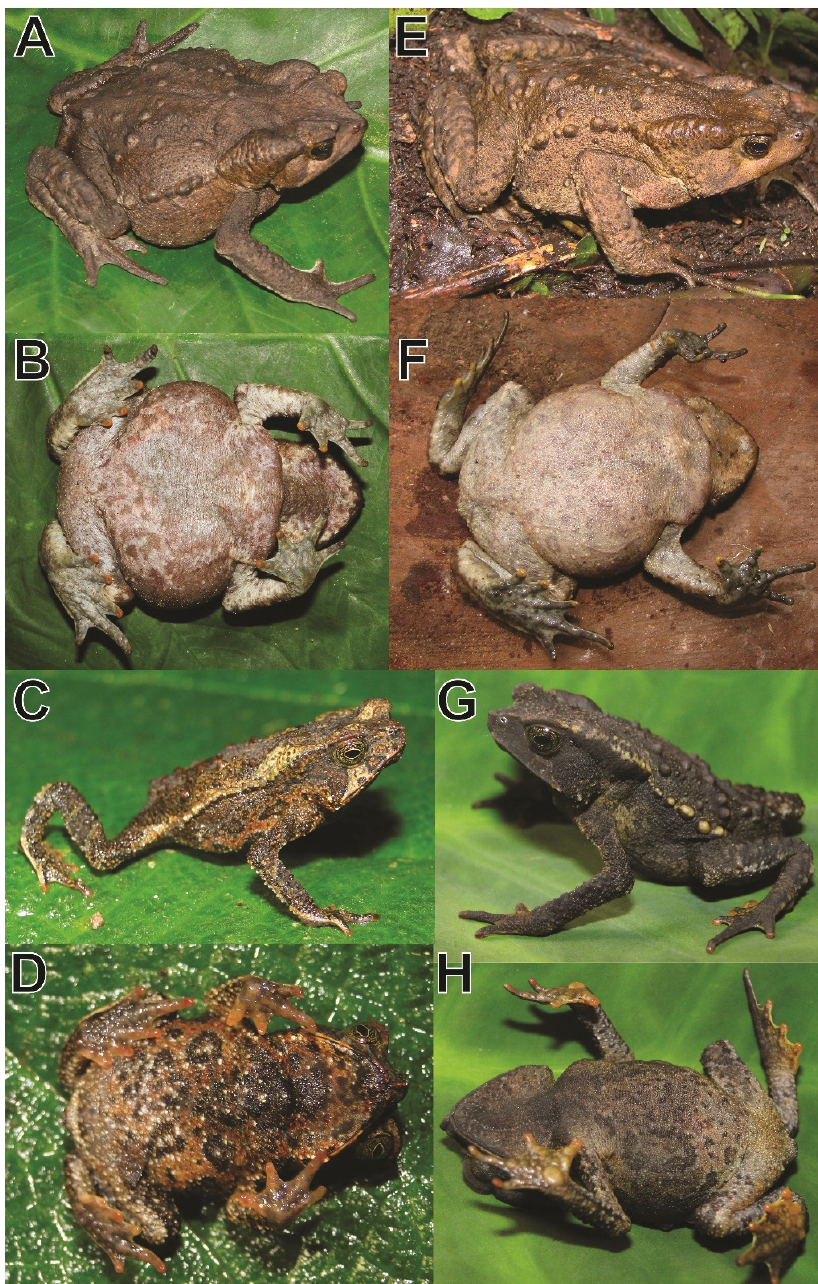
Figure 6. Adult females and juveniles of Rhinella moralesi sp. nov. Female (CORBIDI 20372, SVL 91.6 mm) in dorsal ( A ) and ventral ( B ) views, female (CORBIDI 713, SVL 90.6 mm) in dorsal ( E ) and ventral ( F ) views. Juvenile (CORBIDI 20301, SVL 26.9 mm) in lateral ( C ) and ventral ( D ) views, and juvenile (CORBIDI 18862, SVL 41.3 mm) in lateral ( G ) and ventral ( H ) views. Photos by P.J. Venegas ( E ‒ H ) and L.A. García-Ayachi ( A ‒ D ).